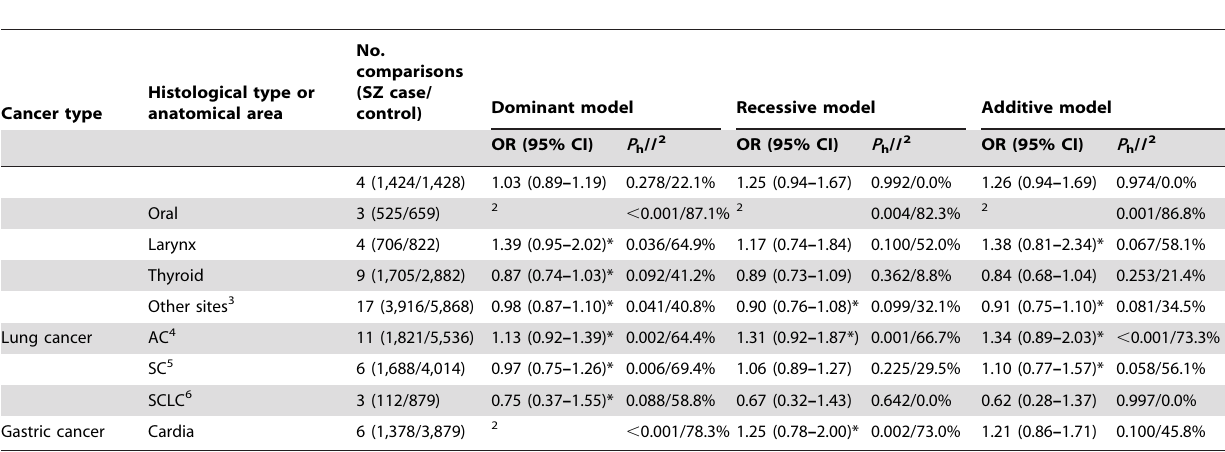
Table 4. Summary ORs (95% CI) for the XRCC1 Arg399Gln polymorphism categorized by histological type or anatomical area in a specific tumor site 1 .